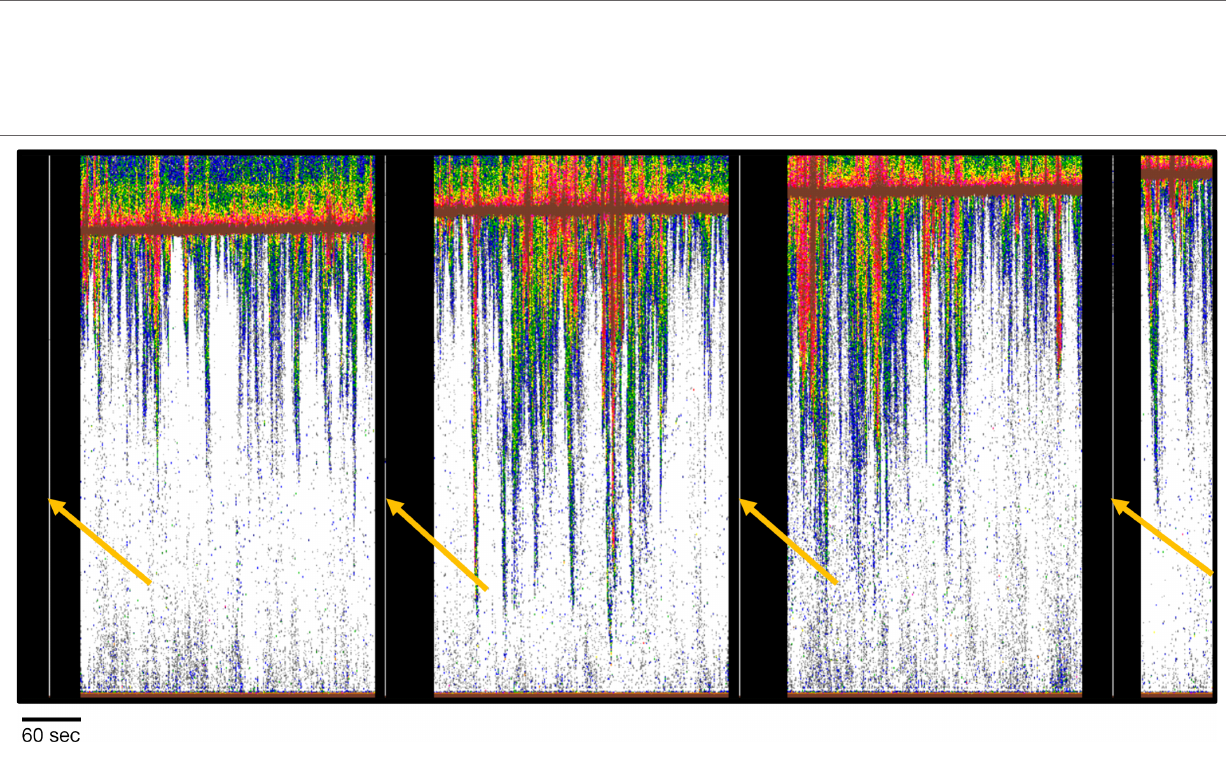
FIGURE 7 | Passive data regions (black vertical bars) as identified by Echoview algorithms. Note the white vertical lines marked by yellow arrows within the black passive data regions. The white vertical lines are single pings or a few pings misclassified by the Echoview algorithm. Data: stationary data with echosounder in upfacing orientation, active data recorded for 5 minutes and passive data for one minute every half hour at the Minas Passage